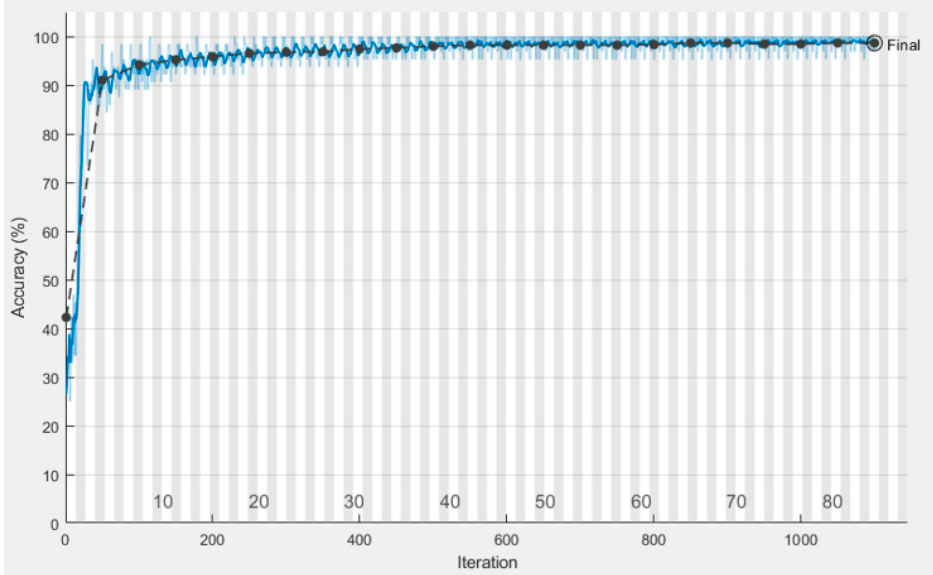
Figure 10. Validation accuracy.